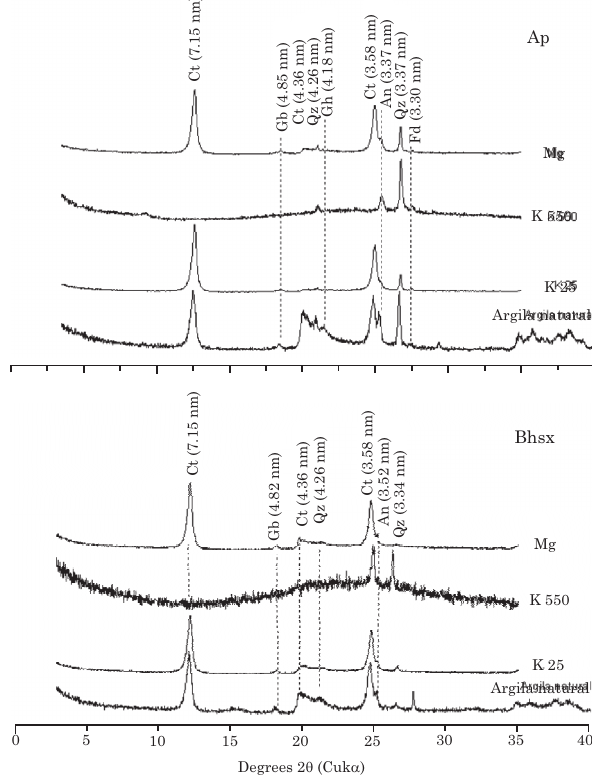
Na figura 2, é apresentado o difratograma de raios-X do perfil 6, representante da área de tabuleiro.